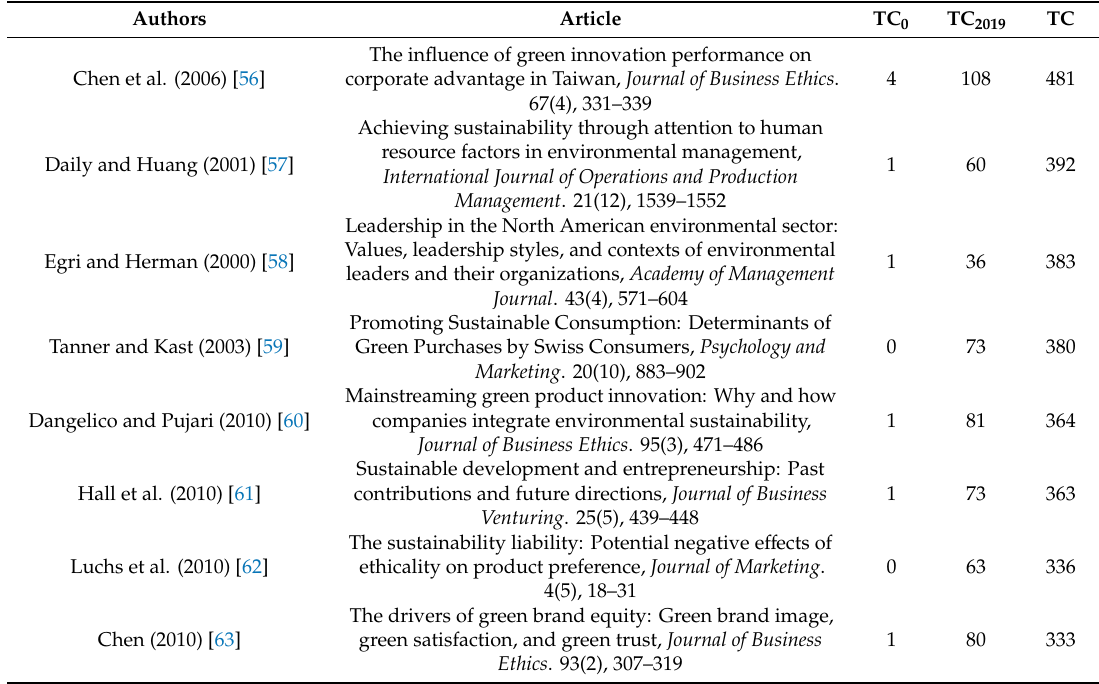
Table 6. Topmost productive articles in the field of green